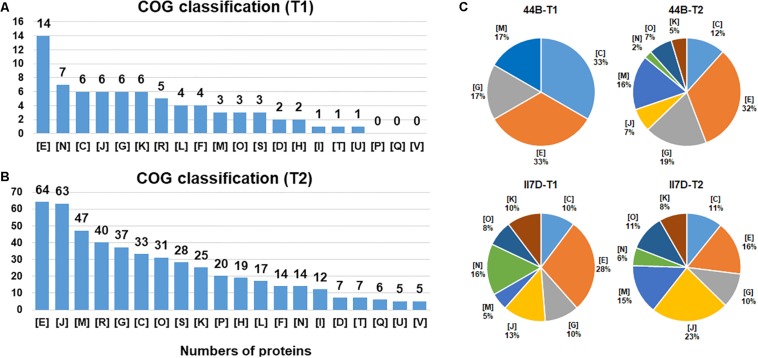
Functional category distribution of proteins identified from Y. enterocolitica cells at low temperature. (A) The number of identified proteins belong to each functional category is shown under cold stress after 2 h (T1). (B) The number of identified proteins belong to each functional category is shown under cold stress after 24 h (T2). (C) The percentage of differential expressed proteins that belong to each functional category in II7D and 44B is shown under cold stress in two time (T1 and T2). COG categories are as follows: C: energy production and conversion; D: cell division and chromosome partitioning; E: amino acid transport and metabolism; F: nucleotide transport and metabolism; G: carbohydrate transport and metabolism; H: coenzyme metabolism; I: lipid metabolism; J: translation, ribosomal structure and biogenesis, K: transcription; L: DNA replication, recombination and repair; M: cell wall/membrane/envelope biogenesis; N: cell motility; O: post translational modification, protein turnover, chaperones; P: inorganic ion transport and metabolism; Q: secondary metabolites biosynthesis, transport and catabolism; R: general function prediction only; S: function unknown; T: signal transduction mechanisms; U: intracellular trafficking, secretion, and vesicular transport; V: defense mechanisms.